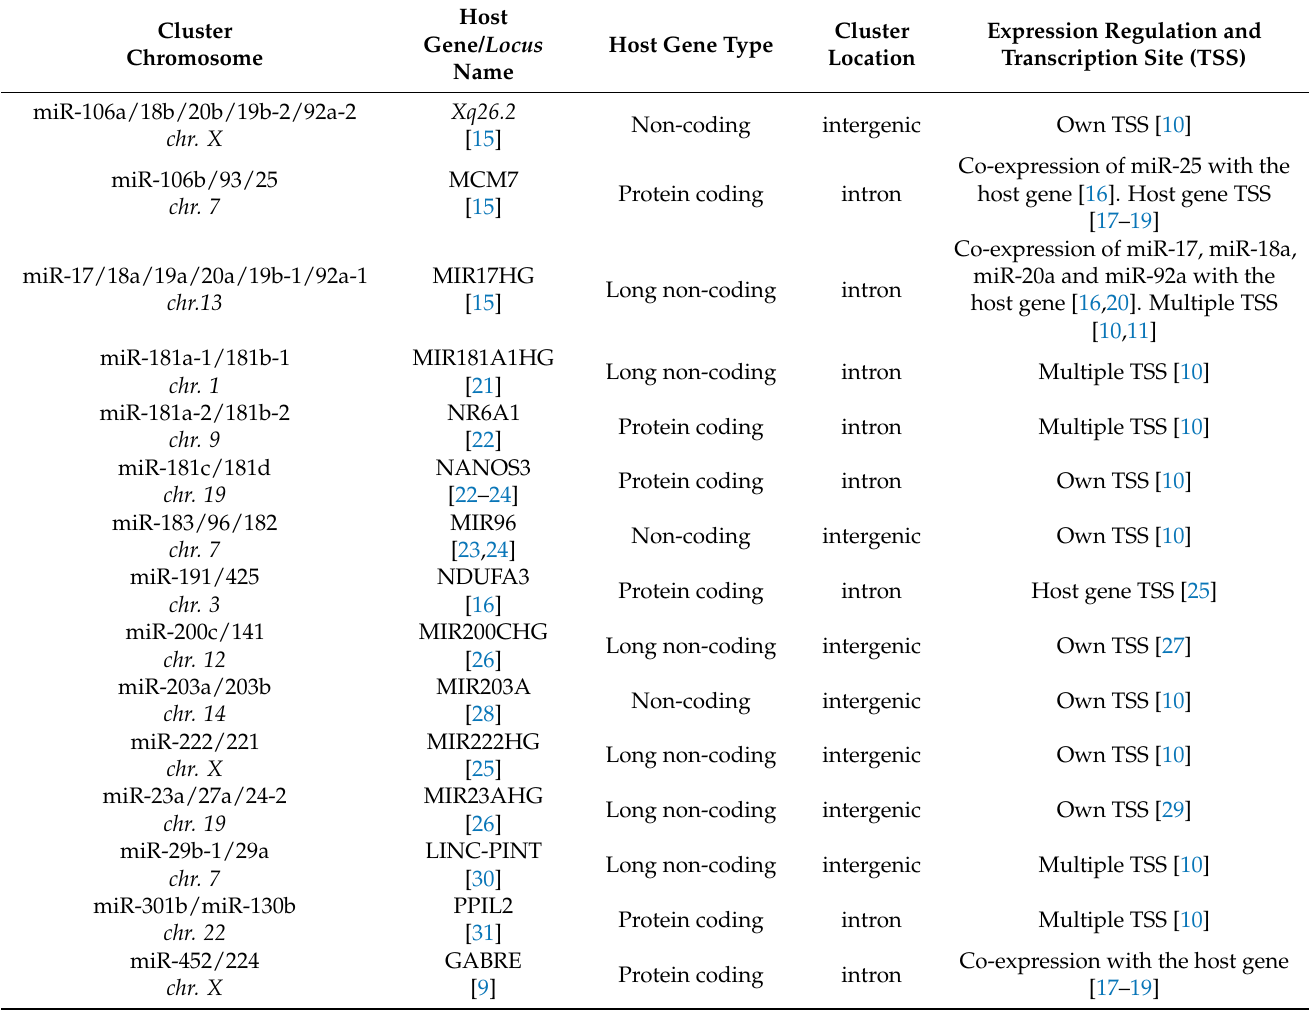
Table 1. Host gene and genomic location of miRNA